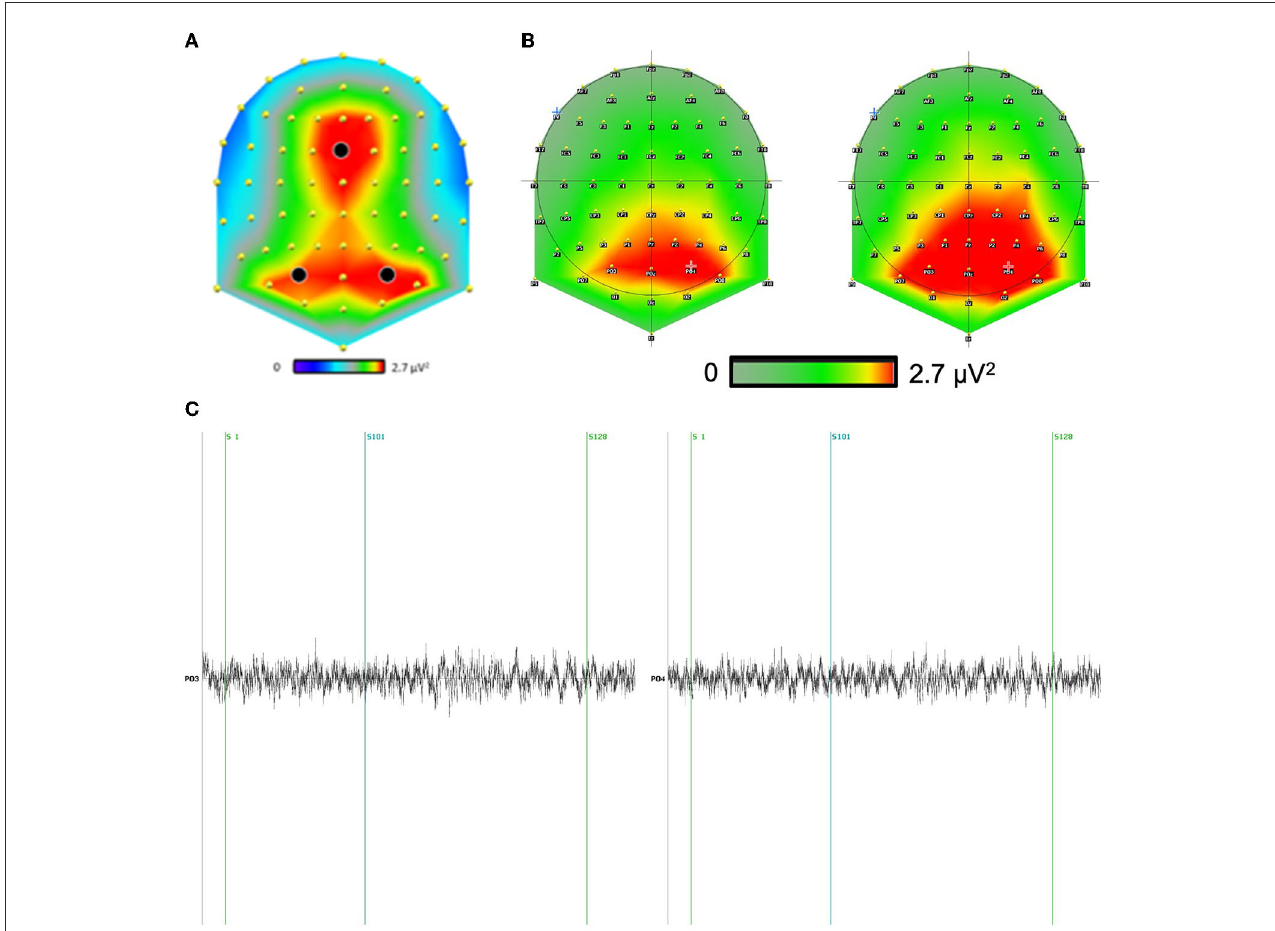
FIGURE2 (A) The theta scalp distribution revealed two strong clusters of activity: one in the frontal site and one in the bilateral parieto-occipital sites. (B) We included the scalp theta distribution for both conditions above. We have focused our analysis on the electrodes with the largest differences. Indeed, the main difference between conditions is mainly a global increase of the theta signal in the direction condition as compared to distance condition, independently of sites. (C) Example of a typical raw channel focused on PO3-PO4 (maximum effect) during question distance (S1) and response distance (S101) for a correct answer